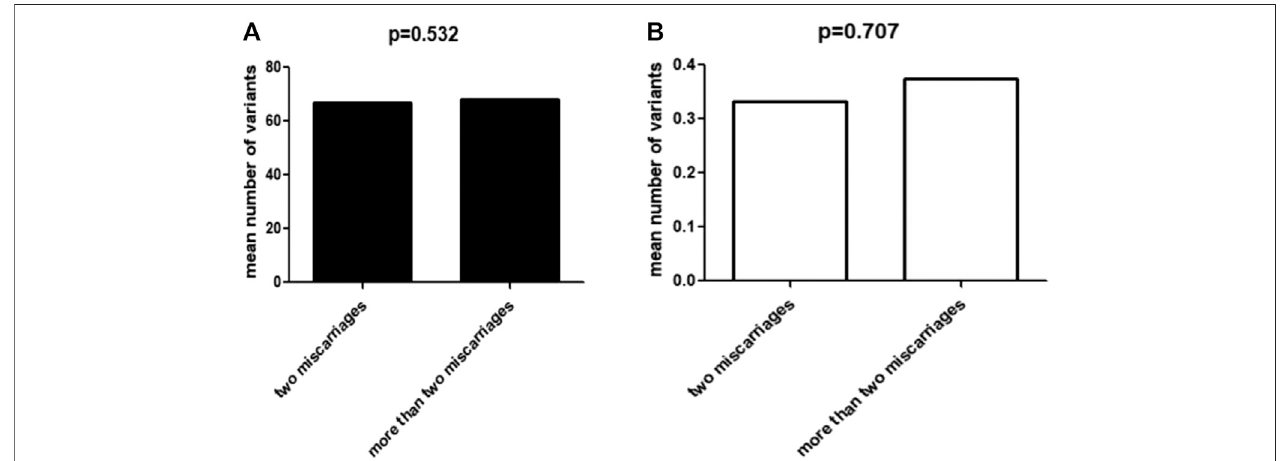
FIGURE 1 | Correlation between miscarriage phenotype and variant accumulation. (A) The mean number of total deleterious variants in two groups with miscarriagesandmorethantwomiscarriages,respectively. (B) ThemeannumberofdeleteriousvariantsofRPL-relatedgenesintwogroupswithmiscarriagesandmore than two miscarriages,